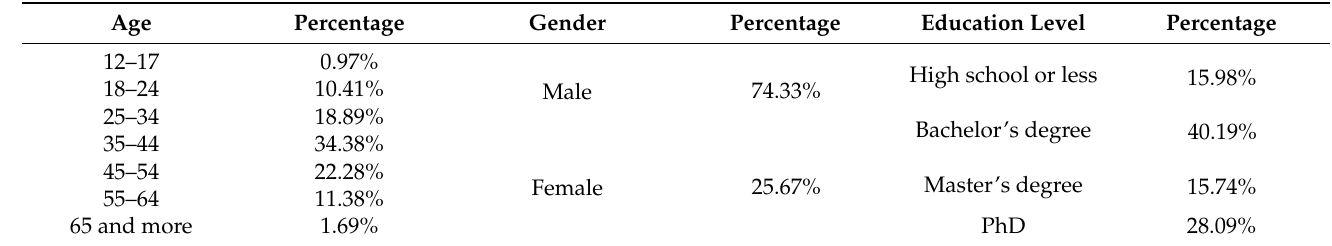
Table 1. Demographic details of